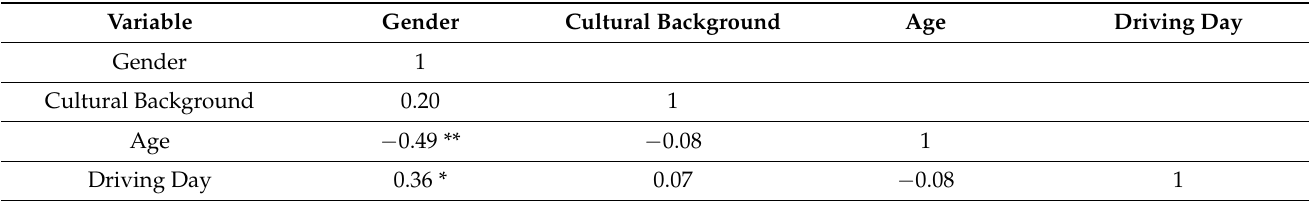
Table 9. Correlation